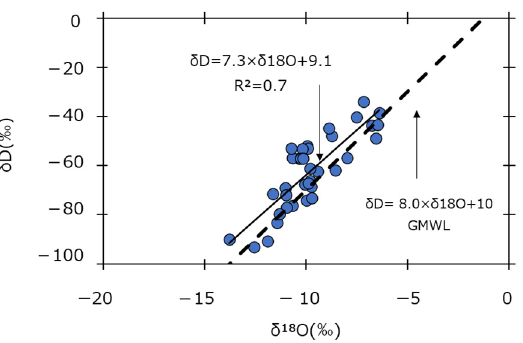
Figure 8. Relationship between δ D and δ 18 O in the monthly precipitation at Hirosaki City, and a plot of the global meteoric water line (GMWL).